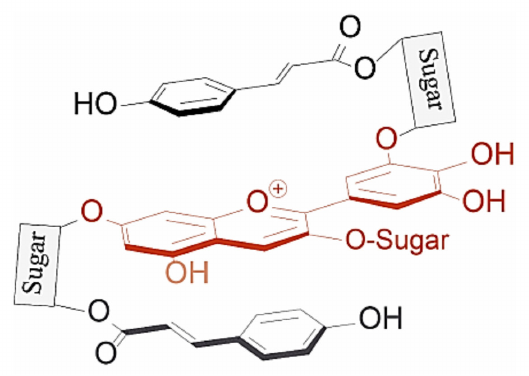
Figure 9. Typical structure of poly-acylated anthocyanins allowing non-covalent interaction be- tween the anthocyanin chromophore and covalently linked acyl moieties (intramolecular co- pigmentation) [25].